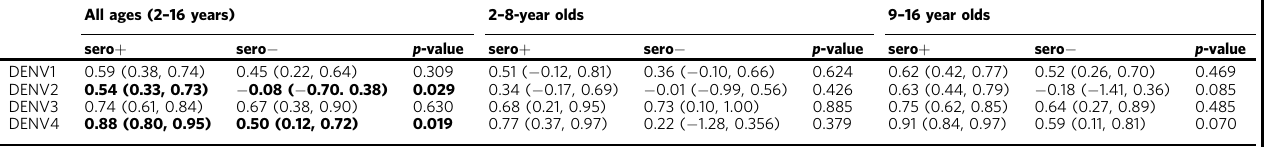
Table 3 Vaccine ef fi cacy estimates by baseline serostatus, serotype and age-group obtained with imputation All ages (2 – 16